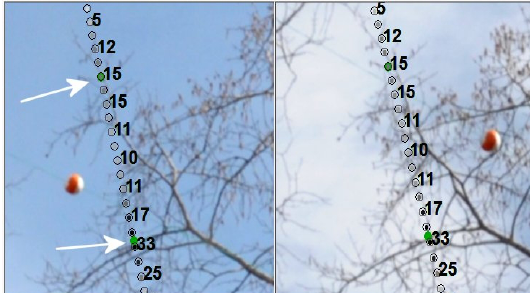
Figure. 9. A 2011b pulse intersecting an aspen branch. The oblique image pair views the targets from a 20-m distance with a baseline of 5 m. Amplitude values at 1-ns sampling are su- perimposed as dots coded in grayscale. The arrows depict the first and second echoes. Such oblique images and those collinear with the pulse help clarify, which targets contribute to the backscattering. A sphere (CP) is shown in the